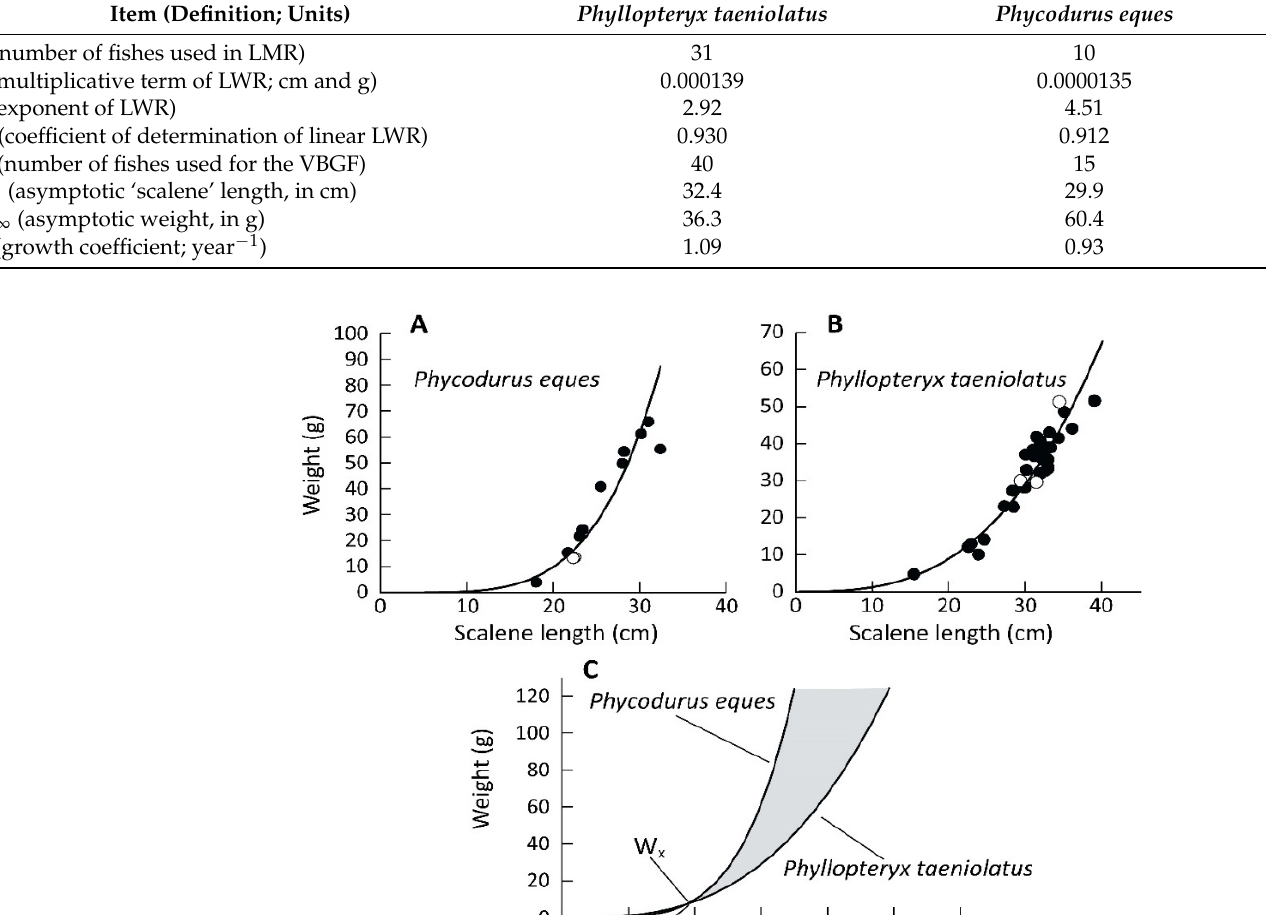
Table 4. Parameters of the length–weight relationship (LWR) and of the von Bertalanffy growth function (VBGF) estimated for the data in Tables 1 and 2, with both sexes combined.